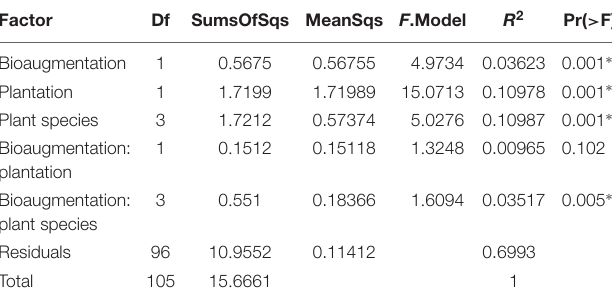
TABLE 2 | PERMANOVA analysis of the effects of the plantation, plant species identity and bioaugmentation on fungal community structure in the substrate, based on Bray–Curtis dissimilarity